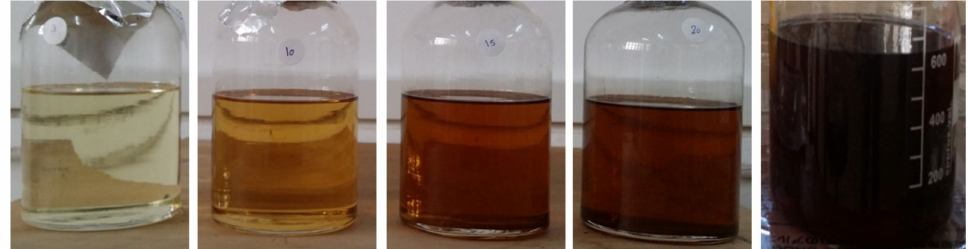
Figure 1. Aged transformer oil samples from left to right: 3-day, 10-day, 15-day, 20-day, and 30-day aging duration,